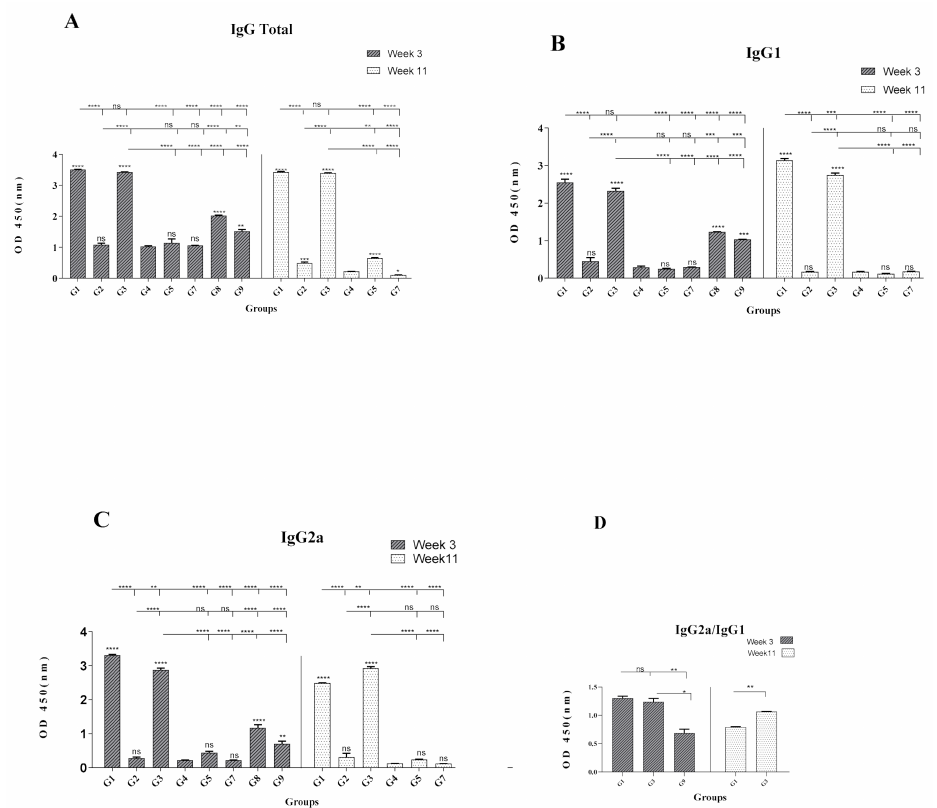
Figure 4. Antigen-specific total IgG, IgG1, and IgG2a antibody responses in vaccinated and control mice groups. Sera were obtained from each group’s mice and pooled ( n = 8) and tested for anti-rCore- rNS3 proteins at W3 and W11. Panel ( A ) shows specific total IgG levels, panel ( B ) indicates specific IgG1, panel ( C ) shows specific IgG2a, and panel ( D ) indicates the IgG2a/IgG1 ratio. All samples were measured in duplicate. Data are represented as mean ± SEM. Statistical analyses were done by one-way ANOVA. ( p < 0.05 denoted as *, p < 0.01 denoted as **, p < 0.001 denoted as ***, p < 0.0001 denoted as **** and ns denoted as non-significant). The asterisks shown directly above the bars indicate statistically significant differences between vaccinated groups and mice’s control group